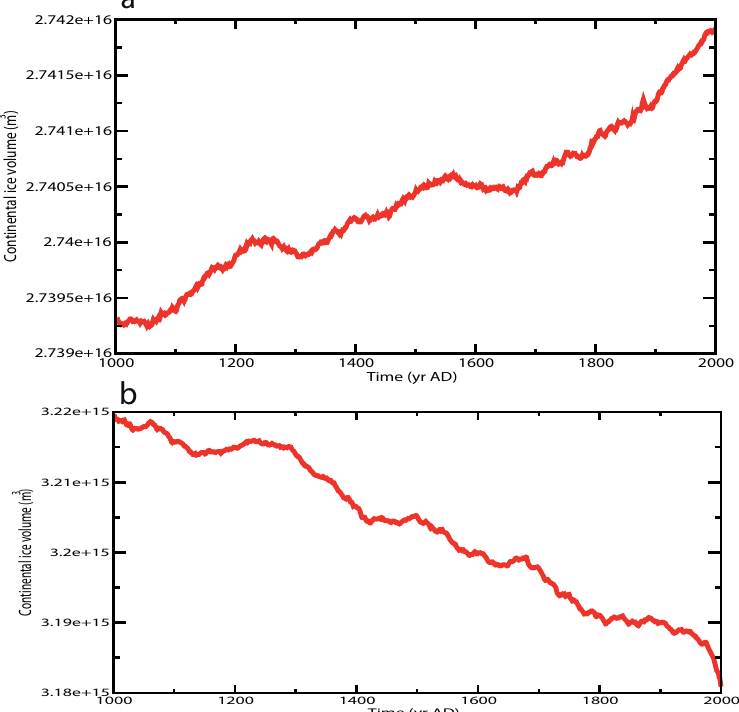
Fig. 17. Continental ice volume changes during the last millennium simulated by AGISM for (a) Antarctic and (b) Greenland ice sheets. In this particular example, the Greenland ice volume budget is equivalent to a positive sea level contribution of about 10cm over the entire period. The Antarctic ice volume budget is slightly positive but cannot be directly related to sea level change because of ice grounded below sea level. Variability in both indices on centennial timescales arises from the climate forcing and dynamical ice-climate interactions. The modelled trend is not a robust feature of AGISM, but contains a significant component from the model coupling procedure at 500AD and the specific model parameters selected for ECBilt and CLIO.